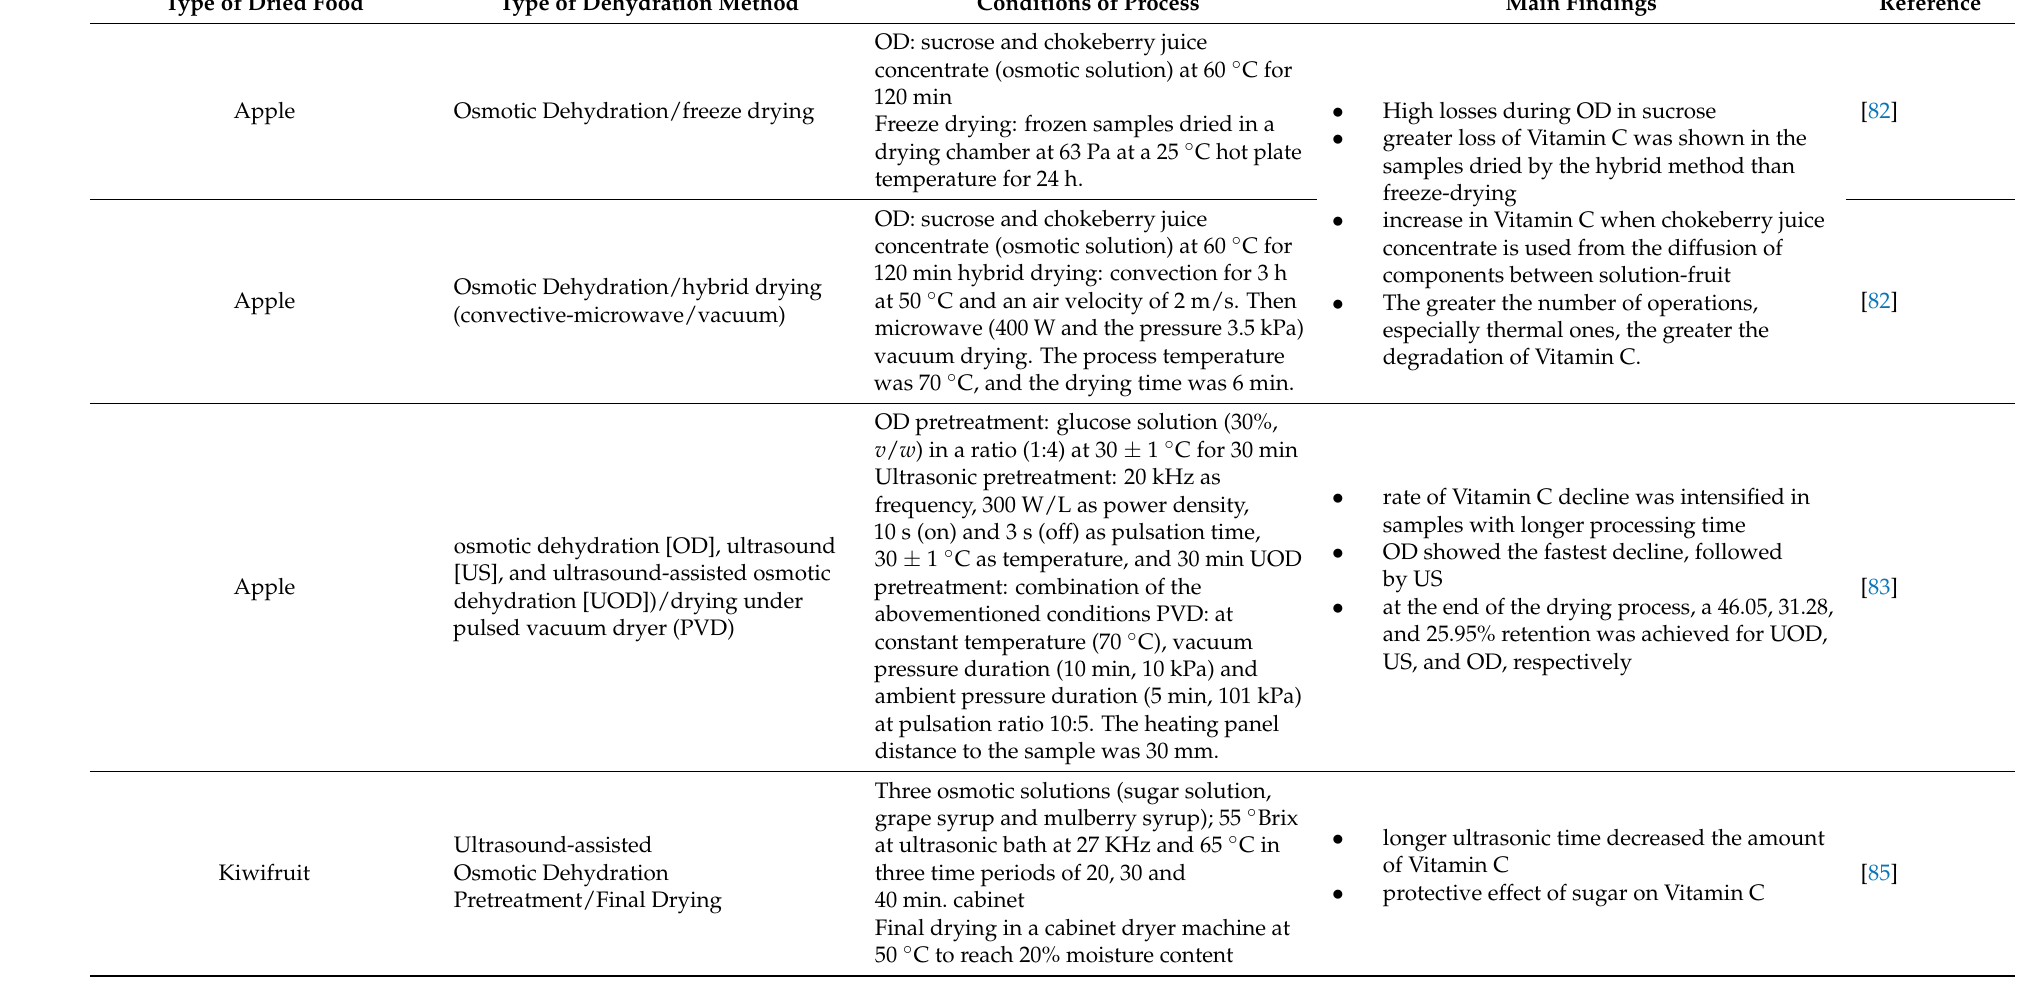
Table 1. Vitamin C degradation in dried fruits and vegetables using different modes of dehydration (hurdle technology). Type of Dried